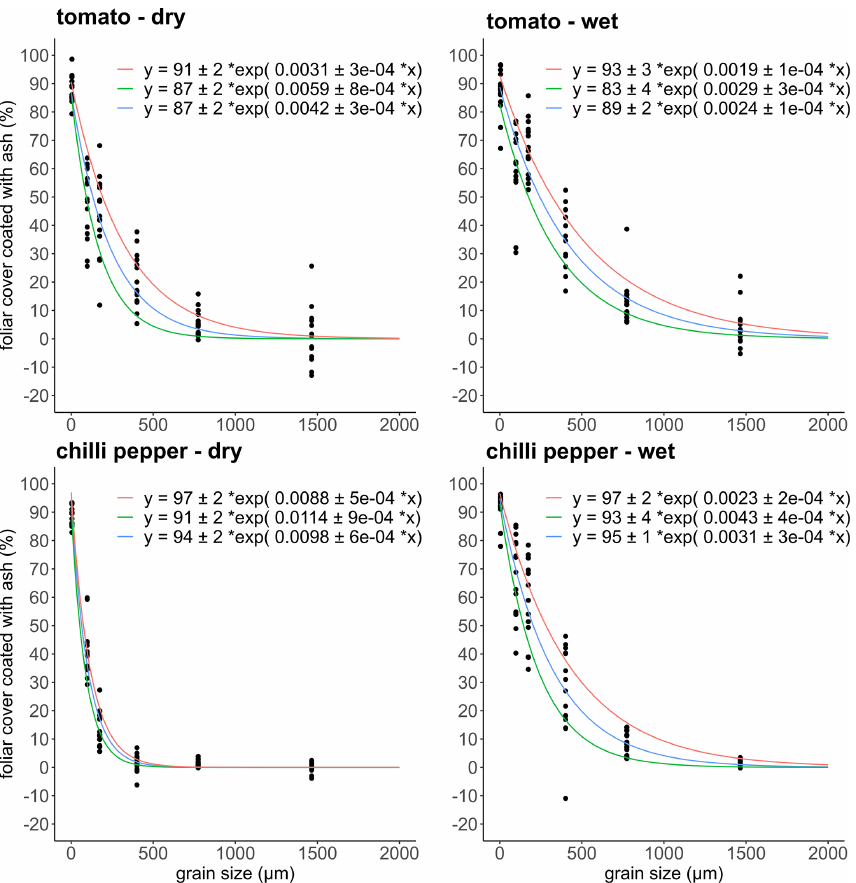
Figure 2. Quantile regression with the first quartile (green), median (blue), and third quartile (red) for tomato and chilli pepper plants in dry and wet conditions at leaf